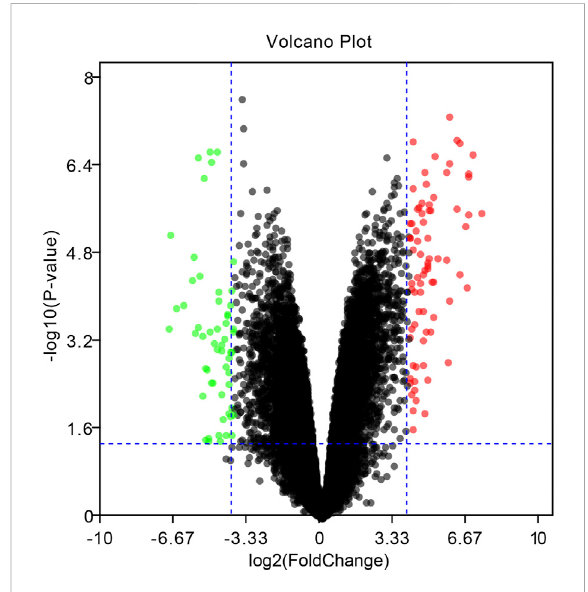
FIGURE 2 Volcano plot of the differentially expressed genes (DEGs) in EBV positive PTCL-U compared to normal controls in GSE34143. Upregulated DEGs are mapped as red spots, and downregulated DEGs are presented as green spots. Genes without notable variation arelabeledasblackspots(cutoffvaluesof|logFC| > 4and p -value <